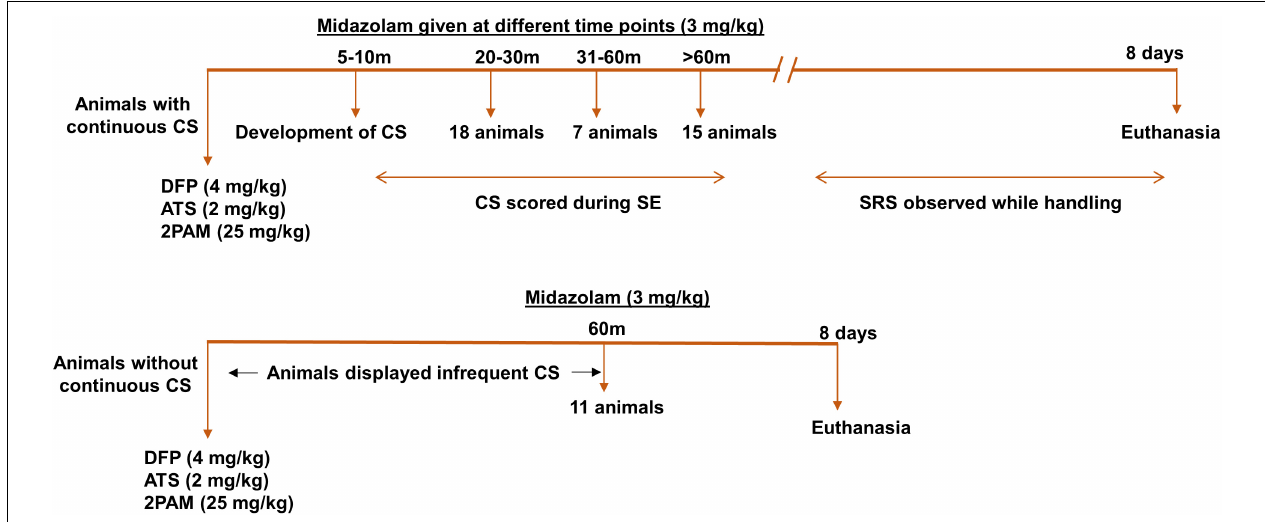
FIGURE 1 | Experimental design. Animals were administered 4 mg/kg DFP (s.c.) immediately followed by 2 mg/kg ATS (i.m.) and 25 mg/kg 2-PAM (i.m.) and either developed continuous convulsive seizures (stage 3-5) or no continuous convulsive seizures. Animals were administered midazolam after animals had 20-min convulsive seizures (around 30-min post DFP), one hour or two hours post DFP to generate various durations of convulsive seizures (CS). Animals without continuous convulsive seizures were given midazolam one hour after DFP. Animals were terminated 8 days post DFP. CS, convulsive seizure, DFP, diisopropylfluorophosphate, ATS, atropine sulfate, 2-PAM,